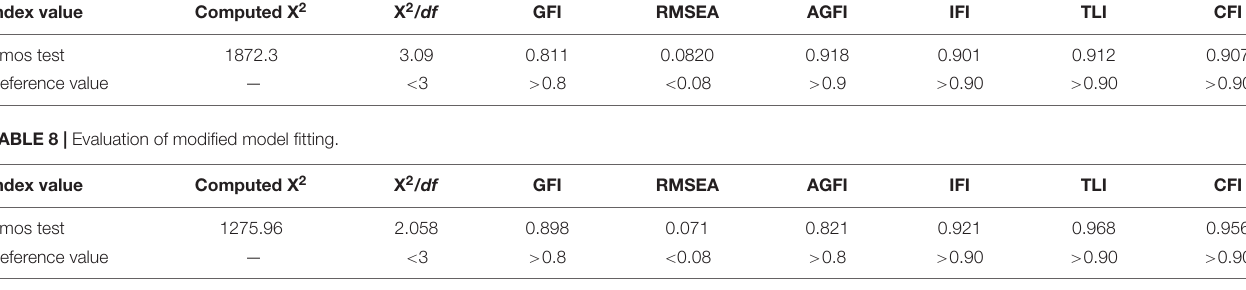
TABLE 9 | Results of the mediating effect based on Bootstrap.